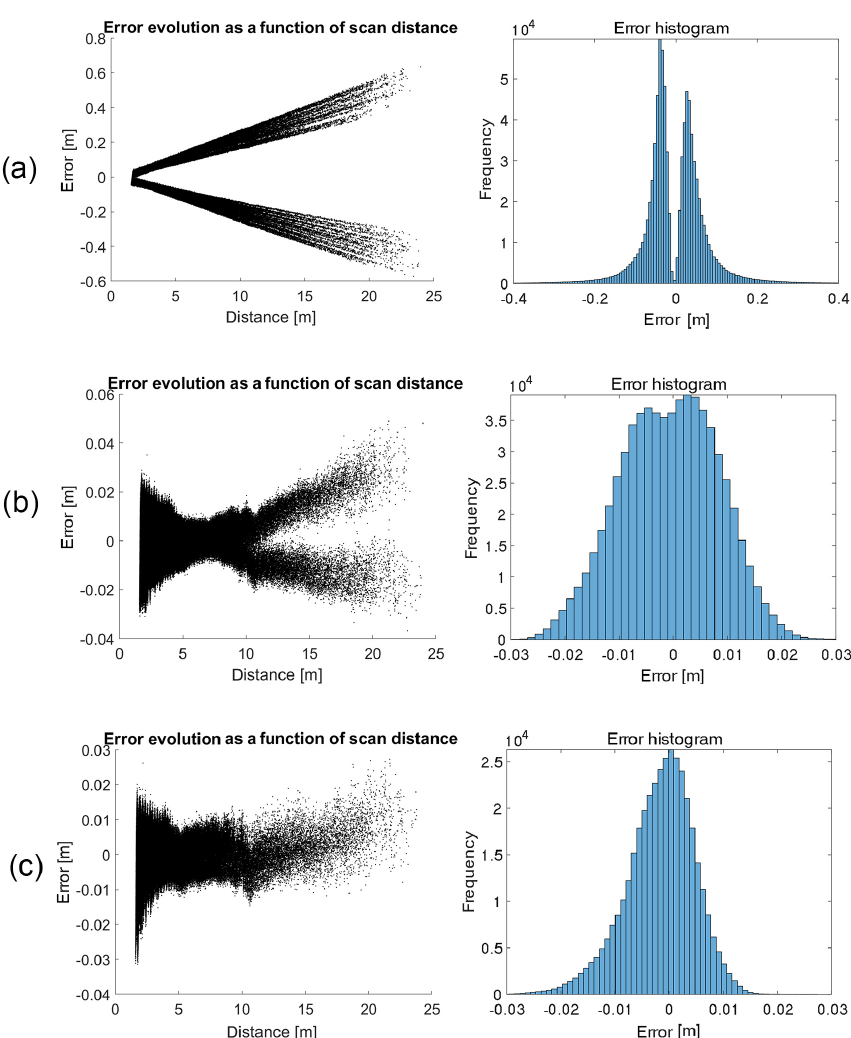
Figure 6. Effects of adjustments in relation to a theoretical plane: (a) error estimation before adjustments; (b) error estimation after adjust- ments; (c) error estimation after adjustments and post-treatment.